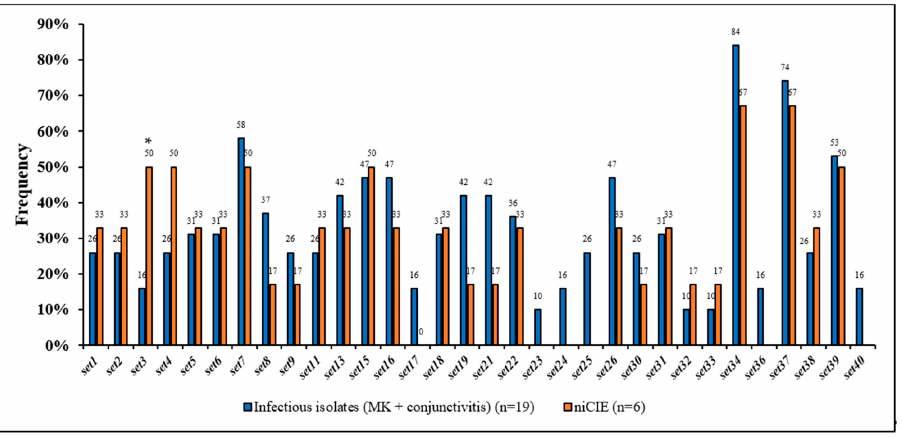
Figure 4. Frequency of 32 enterotoxin-like genes in S. aureus by disease group. *, trend more common in niCIE strains ( p = 0.1).